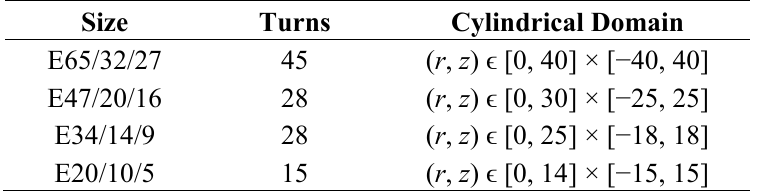
Table 1. Four inductors with different sized E cores used for the